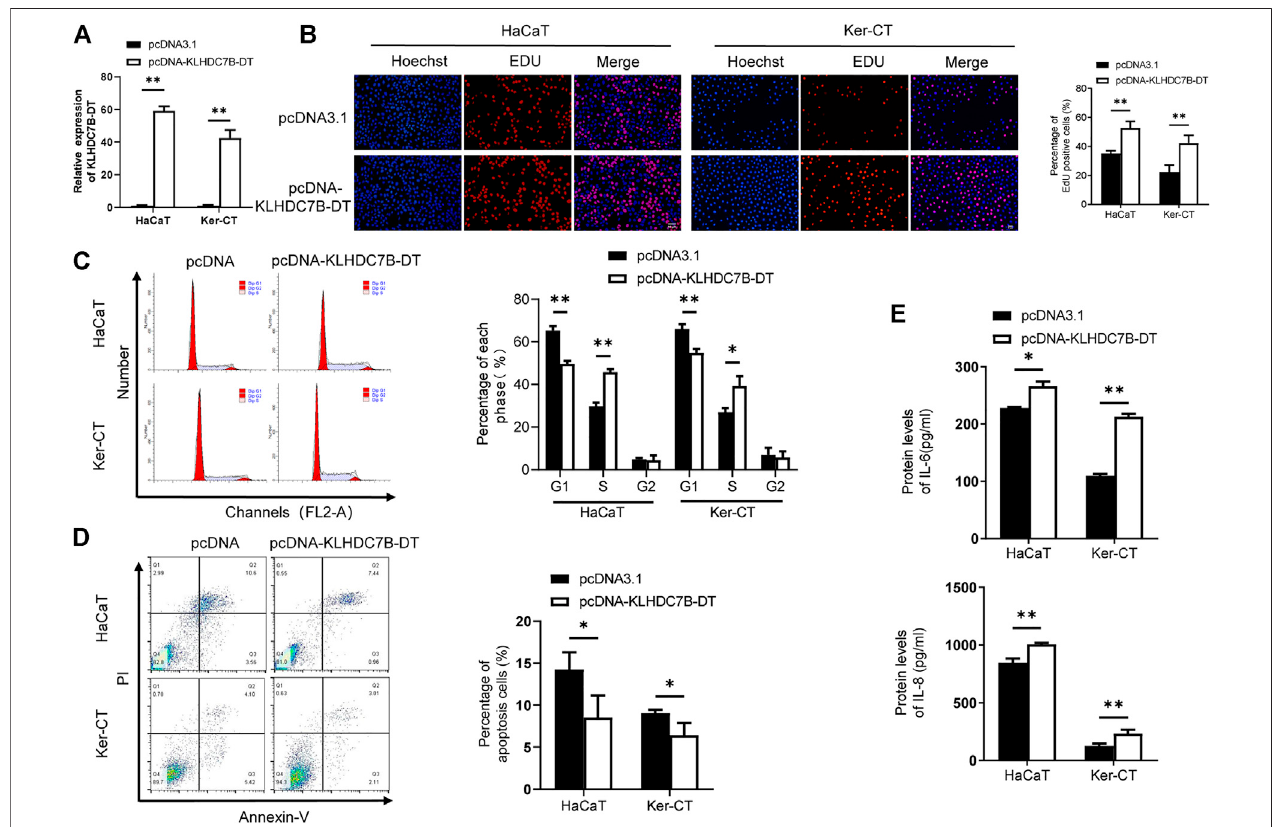
FIGURE 3 | The proliferative and in fl ammatory effects of KLDHC7B-DT overexpression in M5-induced keratinocytes. (A) The ef fi ciency of KLDHC7B-DT overexpression detected by qRT – PCR. (B) Proliferative effects of KLDHC7B-DT overexpression on M5-treated keratinocytes detected by EdU assay. (C) The cell cycle wasdetected by fl owcytometry through PIstaining. (D) Cell apoptosis was detected by fl ow cytometry through Annexin-V/PIstaining. (E) Protein levels of IL-6and IL-8 were detected by ELISA. Data are shown as the means ± SD, * p < 0.05, ** p < 0.01, *** p < 0.001. All experiments were repeated at least three